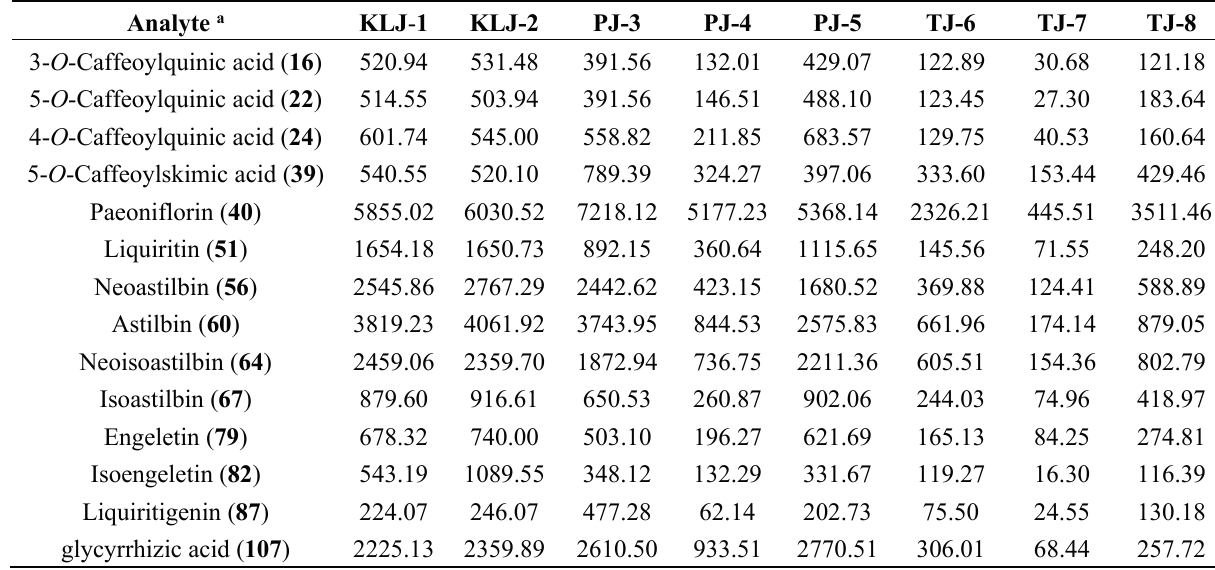
Table 4. The contents of the 14 compounds in different batches of PSORI-CM01 prepations ( n =